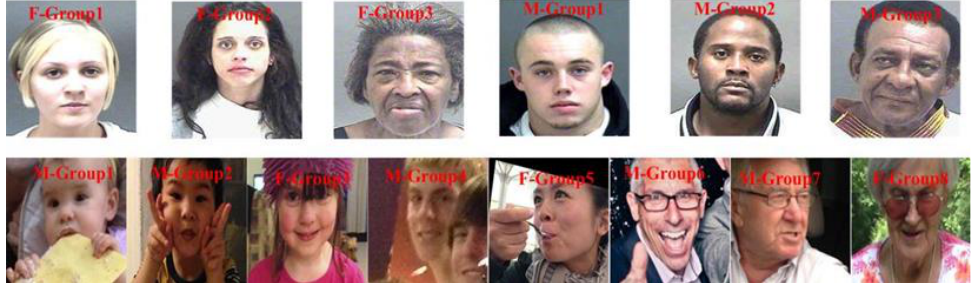
Figure 6. Examples of recognition results from MORPH-II and Adience datasets. Top row: results of MORPH-II. Bottom row: results of Adience.